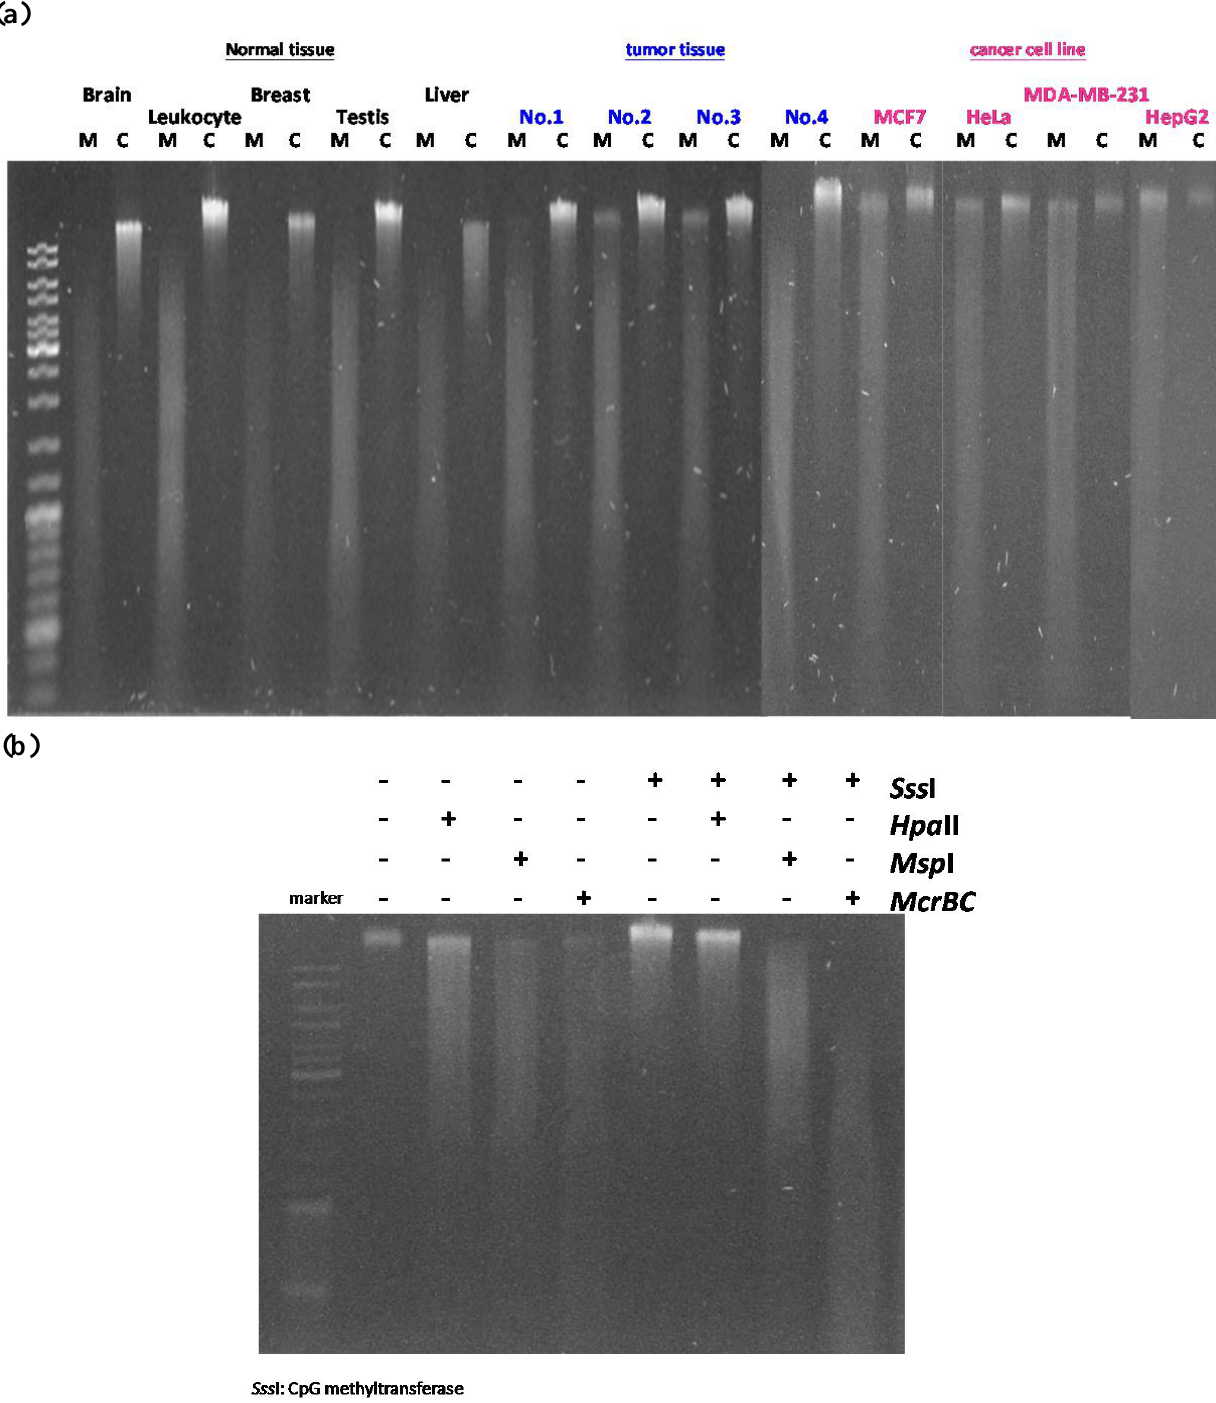
Figure 1. Genomic DNA digested by McrBC. ( a ) Digestion of normal tissue and tumor DNA with McrBC enzyme. Tumors DNA from primary breast tumors and from various tumor cell lines show the presence of McrBC-resistant high molecular weight DNA, whereas the DNAs from normal tissues are cleaved into small fragments. ( b ) The large pieces of McrBC-resistant MCF-7 DNA became sensitive to McrBC digestion after in vitro CpG methylation by SssI methylase (compare 4th lane with the 8th